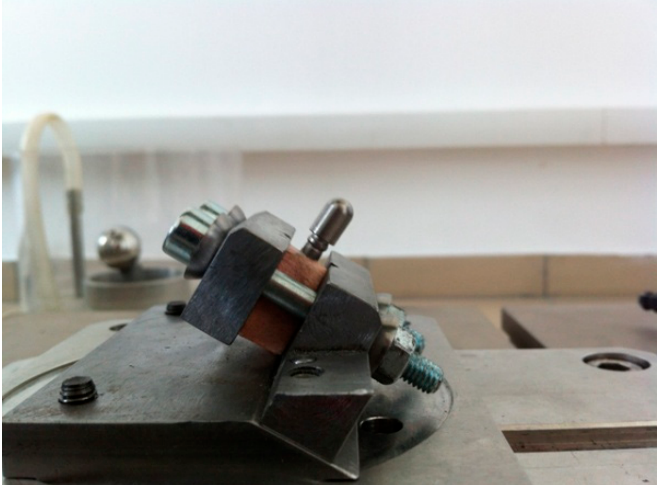
Figure 3. Mounting of the bone block containing the implant in the testing machine (INSTRON 8870 [44] at The National Institute of Research and Development in Mechatronics and Measurement Technique, Bucharest, Romania), at a 30° angle, with 3 mm of the coronal portion above the bone. The abutment is covered by a hemispherical cap specially designed for this test.